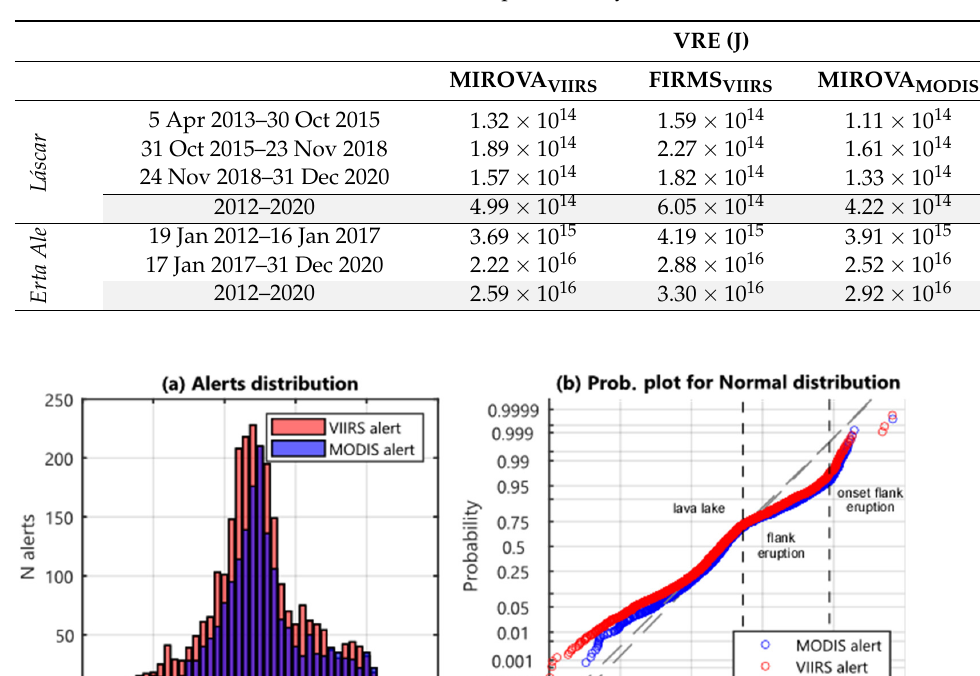
Table 3. Table displaying cumulative total VRE for every L á scar cycle and Erta Ale phase. In grey cells, there are the same values calculated for the period analyzed in this work (2012–2020).